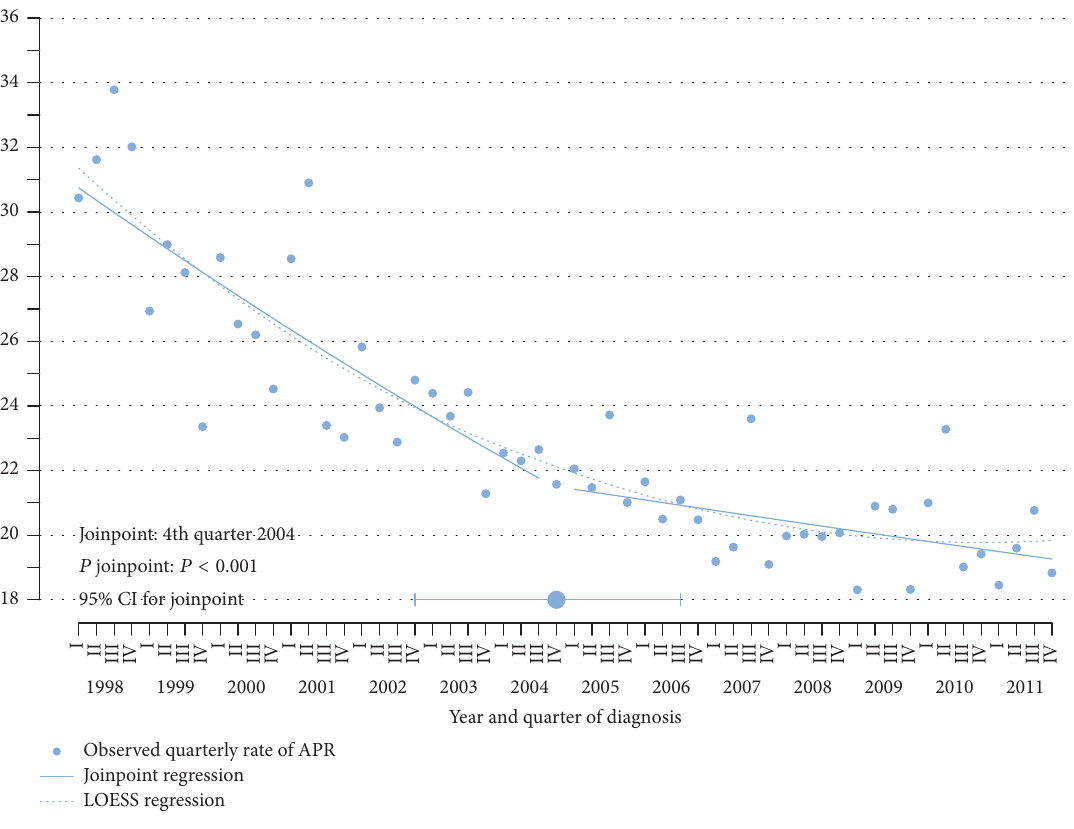
Figure 1: Trend analysis for abdominoperineal resection, 1998 to